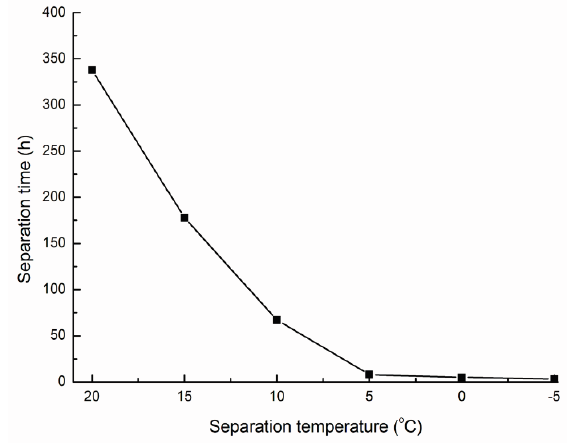
Figure 2. Effect of temperature on time required to separate bio-PA and